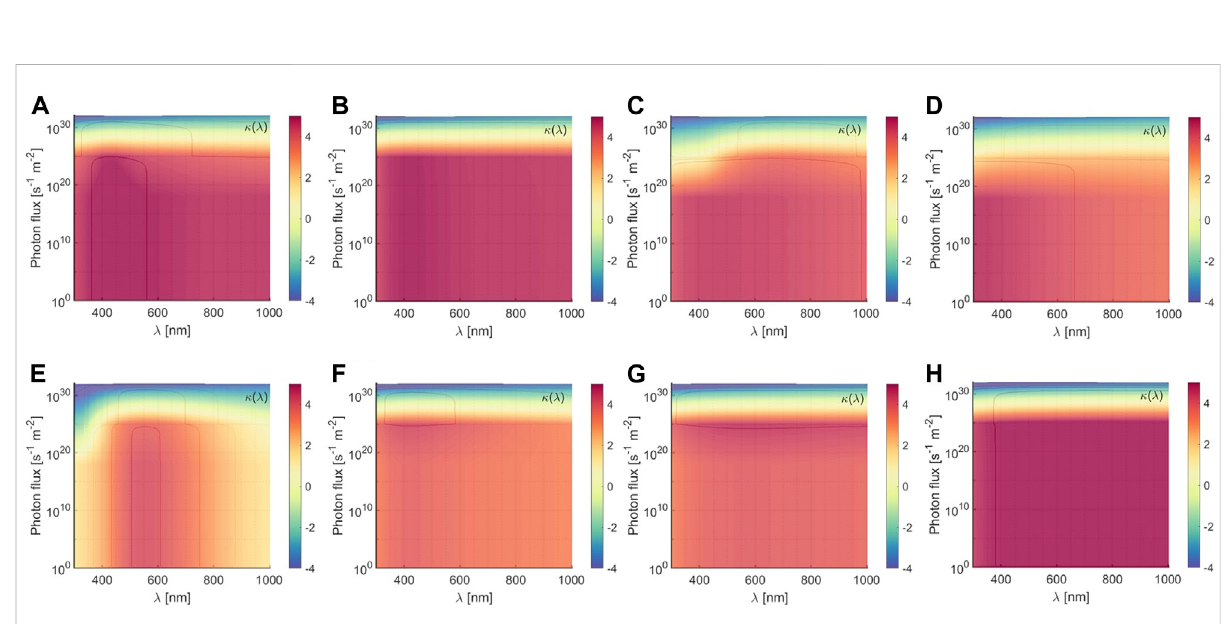
FIGURE 11 Numerical opacity κ ( λ ) [cm 2 g − 1 ] (log scale) of metallic plasmas in the VIS range, as resulting from NLTE CR calculations in FLYCHK, for (A,E) selenium (Se), (B,F) strontium (Sr), (C,G) zirconium (Zr), and (D,H) niobium (Nb), at electron density ρ e = 1.4 · 10 17 m − 3 , and energy k B T e = 2.43 eV (A – D) , and k B T e = 7.88 eV (E – H) . Opacity is shown in the wavelength λ [nm] - external radiation photon fl ux s − 1 m − 2